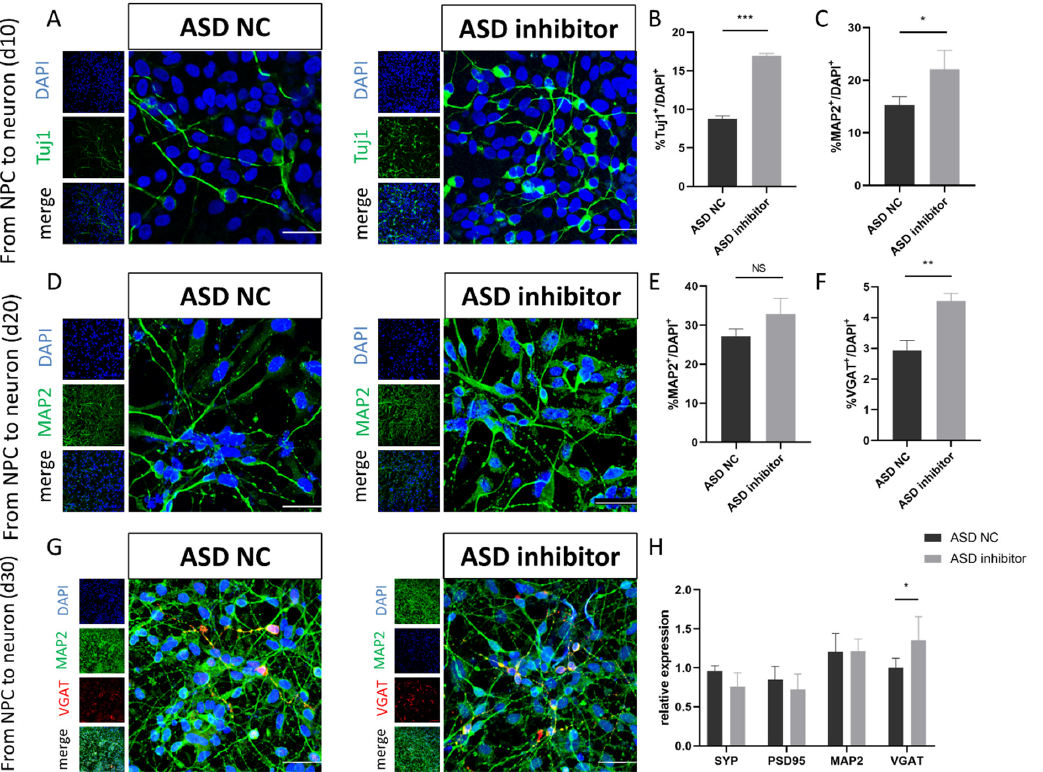
Figure 5. MiR-92a-2-5p modulates the differentiation of ASD-NPCs. ( A , B ) Representative images of TUJ1 (green)-expressing neurons derived from ASD NC and ASD inhibitor NPCs at day 10. DAPI